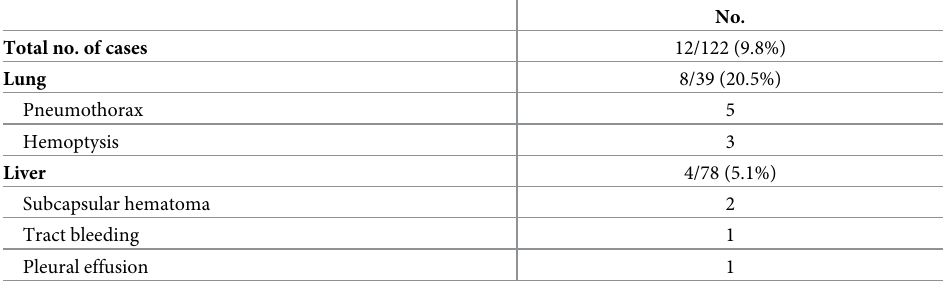
Table 3. Complications.